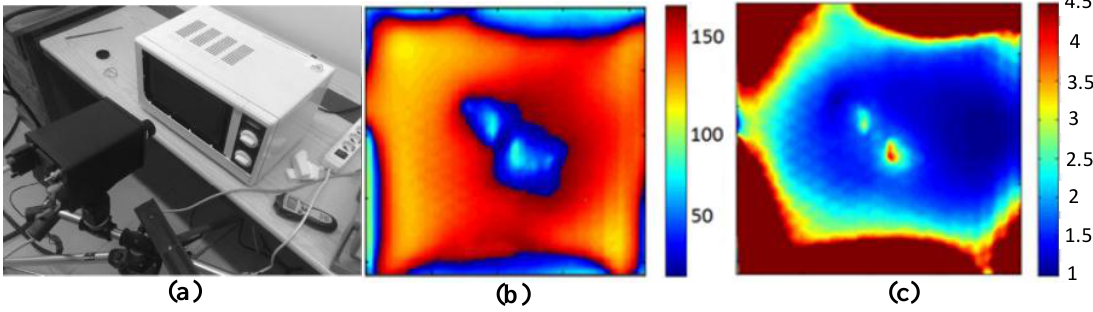
Figure 22. The experimental set-up used for relay ( a ), lock-in phase image ( b ) and amplitude image ( c ) [74].